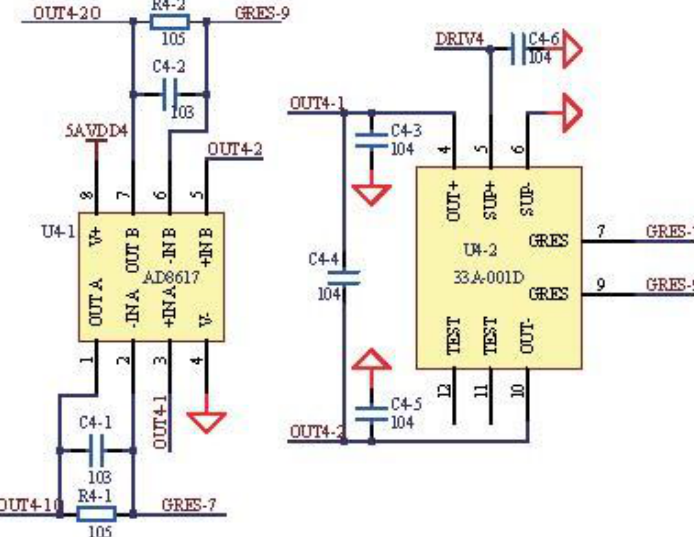
Figure 4. Application circuit of the pressure